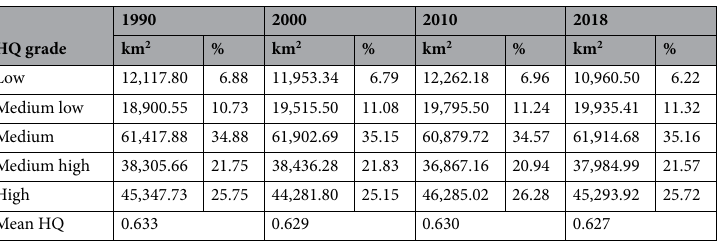
Table 7. Areas and proportions of HQ grades in Guizhou Province over the 1990–2018 period.